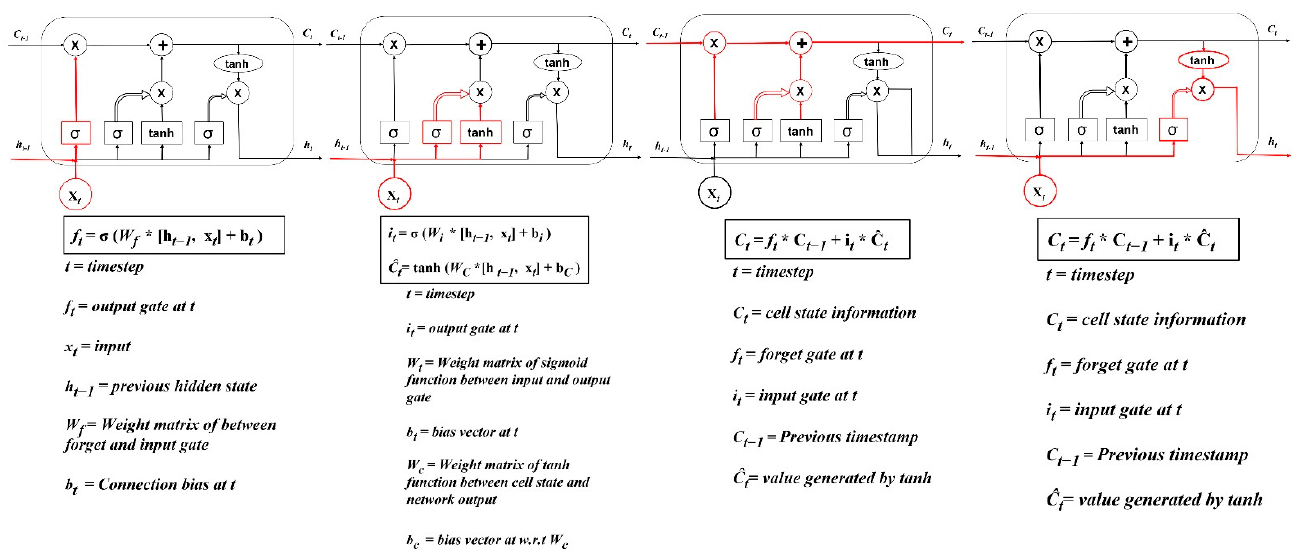
Figure 5. Schematic representation of a LSTM architecture.